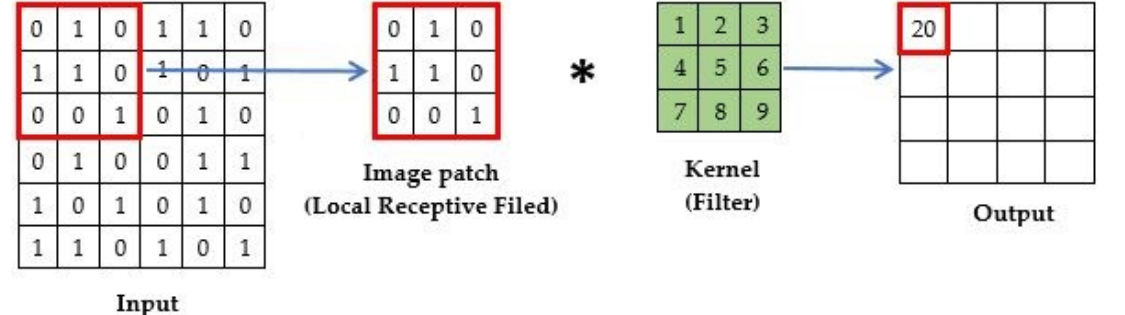
Figure 1. CNN Convolution operation (* represents multiplication).